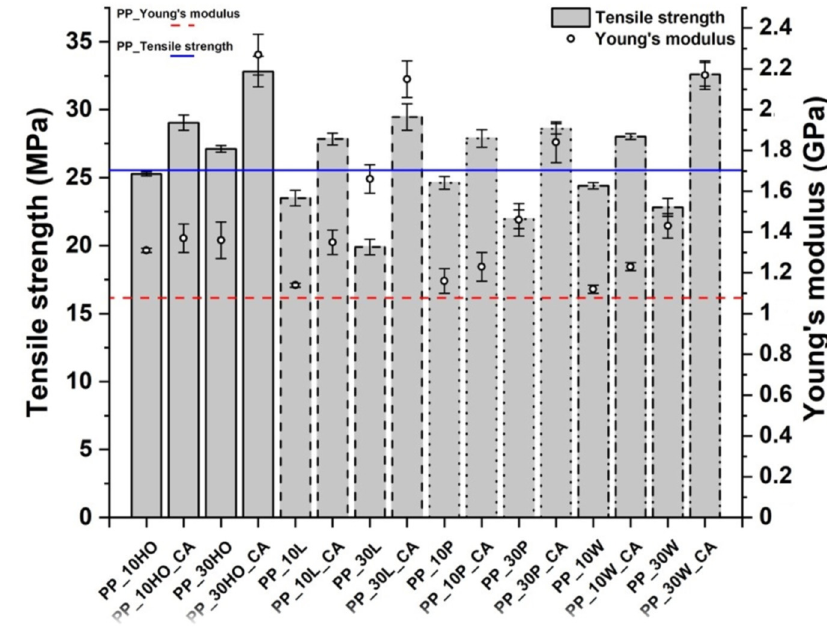
Figure 7. Tensile strength and modulus values of PP-based composites.